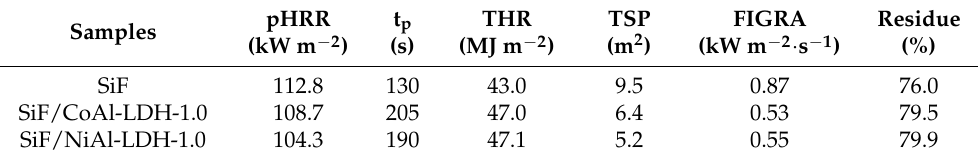
Table 3. Data on the SiF/LDH nanocomposites from the cone calorimeter tests. Samples